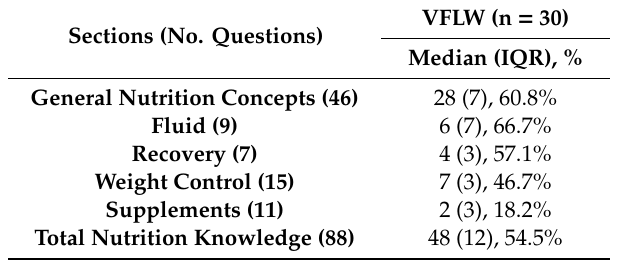
Table 4. Nutrition knowledge scores in VFLW players (median (IQR), percent (%) of correct answers). Sections (No. Questions)